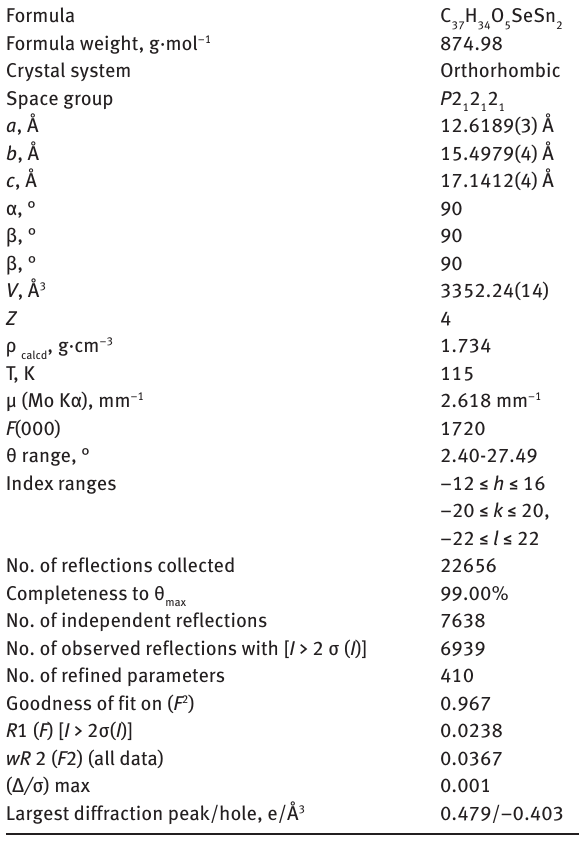
Table 1: Crystal data and structure refinement of 1